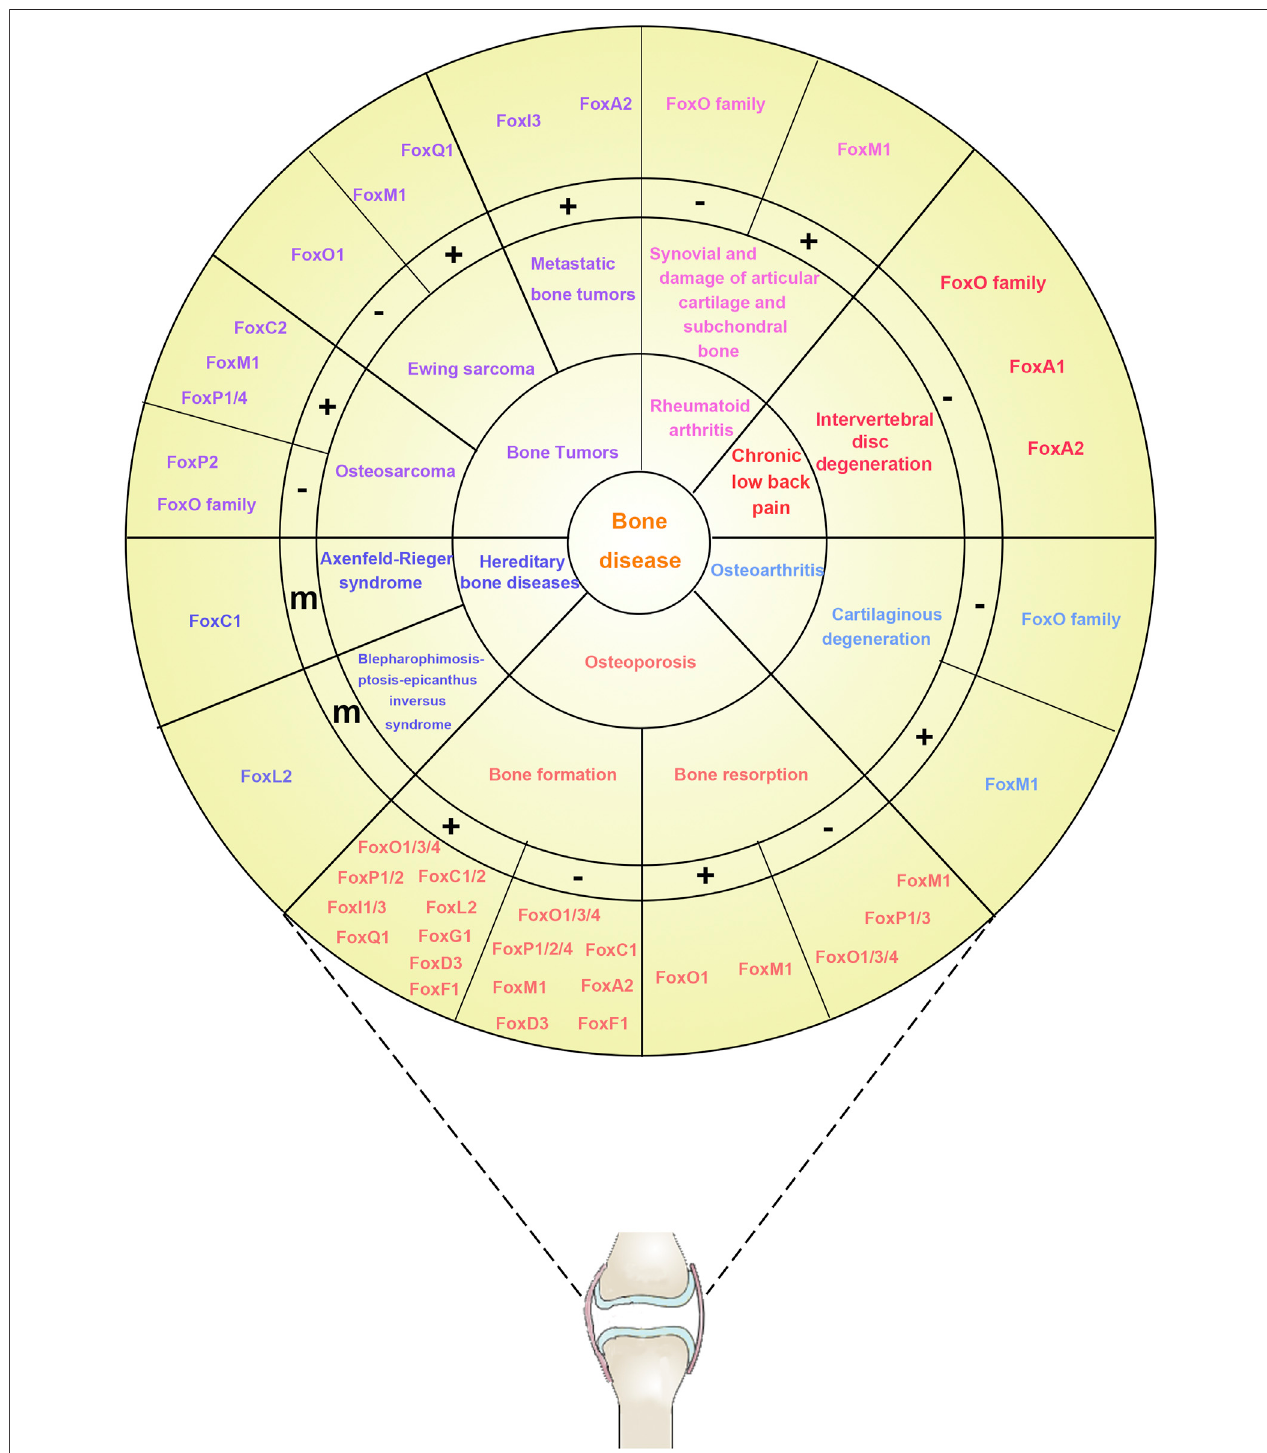
FIGURE 1 | TherelationshipbetweentheFoxfamilyandbonediseases.ThebonediseasesrelatedtotheFoxfamilyaredividedintosixtypeslistedinthe fi rstinnerring(six types of colors, including osteoporosis, osteoarthritis, chronic low back pain, rheumatoid arthritis, bone tumors, and hereditary bone diseases). The characteristics of different diseases are listed in the second inner ring. Osteoporosis, a metabolic bone disease caused by dyshomeostasis of bone metabolism, is closely related with bone formation and boneresorption;Osteoarthritis,achronicjointdiseasecharacterizedbydegenerativechangesinjointcartilage,iscloselyrelatedwithcartilaginousdegeneration;Chroniclow back painisclosely relatedwithintervertebraldiscdegeneration;Rheumatoidarthritis,achronicjointdiseasecharacterized by persistent synovitis and associated damagetothe articular cartilage and subchondralbone, is closely related with synovial and damage of articular cartilageand subchondral bone; Bonetumorsisseparated intometastatic bone